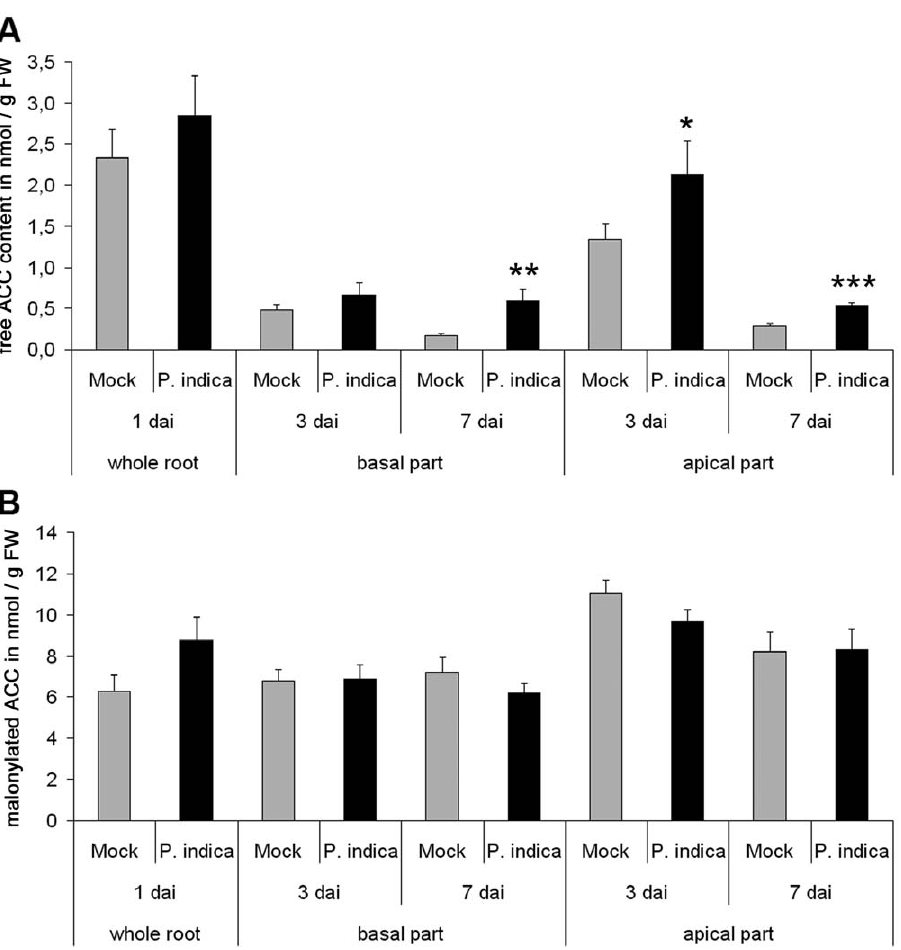
Figure 2. ACC content in barley roots during P.indica colonization. Free ( A ) and malonylated ( B ) 1-aminocyclopropane-1-carboxylic acid (ACC) contents were determined in P. indica and mock-treated roots at 1, 3, and 7 days after treatments. At 1 dai, the complete roots were harvested N and forwarded to ACC measurements. At 3 and 7 dai, the upper two centimeters (basal part) and the remaining part of the roots (apical part) were g FW 2 1 for mock-treated and P. indica -colonized roots. ( A ) Free ACC levels were significantly analyzed separately. Absolute values are given in nmol enhanced at 3 and 7 dai in the apical zone and 7 dai in the basal part as indicated by Students t -test (* P , 0.05, ** P , 0.01, *** P , 0.001). ( B ) Malonylated ACC was not significantly altered during P. indica colonization at any timepoint or in any tissue. Data show the mean content of four biological experiments (with at least two technical repetitions per experiment) and bars indicate standard errors.